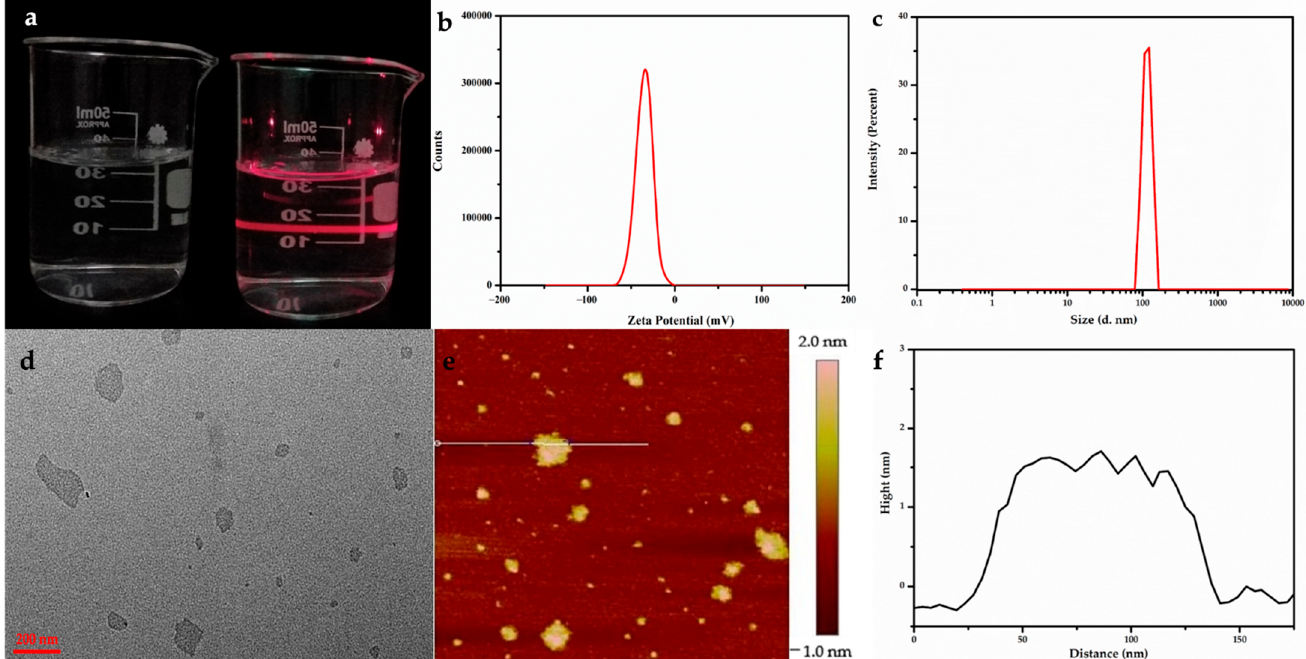
Figure 1. Stable, clear, and transparent sol of Gd/Y nanosheets obtained by ultrasound display typical Tyndall scatter effects ( a ). Zeta potential ( b ) and particle size ( c ) of nanosheet colloidal solution are confirmed to be − 35 mV and ~100 nm. TEM ( d ) and AFM ( e and f ) characterizations of the Gd/Y nanosheets. Black line in ( f ) represents the height profile of the section in ( e ) labeled with the white line.